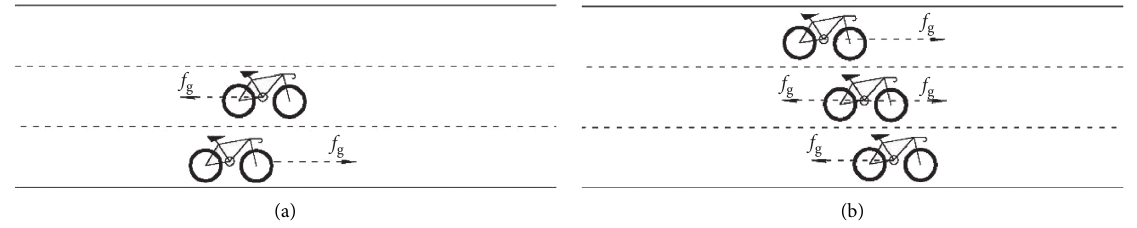
Figure 3: The schematic diagrams of shoulder group force. The group sizes in (a) and (b) are, respectively, two and